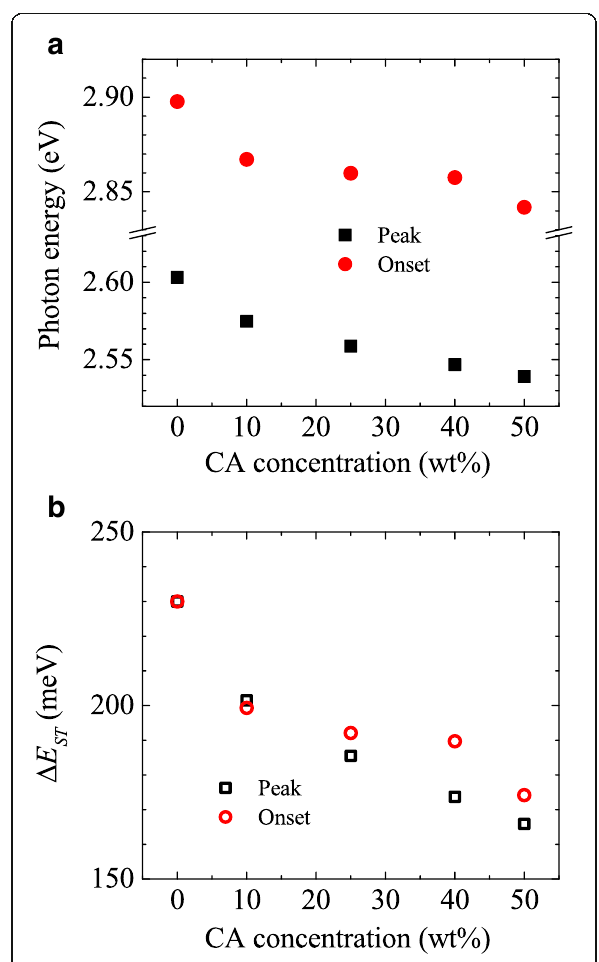
Fig. 4 a Spectral position of fluorescence and ( b ) estimated Δ E ST as a function of CA concentration. In panel a , solid squares and circles represent the peak photon energy and the onset of fluorescence, respectively. In panel b , open squares and circles indicate Δ E ST values estimated from the peak photon energy and the onset, respectively, under the assumption that Δ E ST is 230 meV at 0 wt% CA concentration